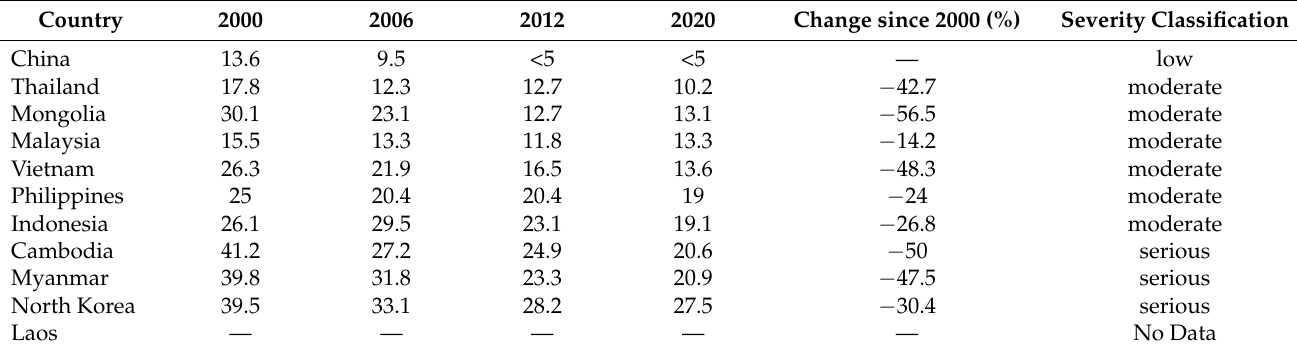
Table 9. Hunger index in East and Southeast Asian Countries.